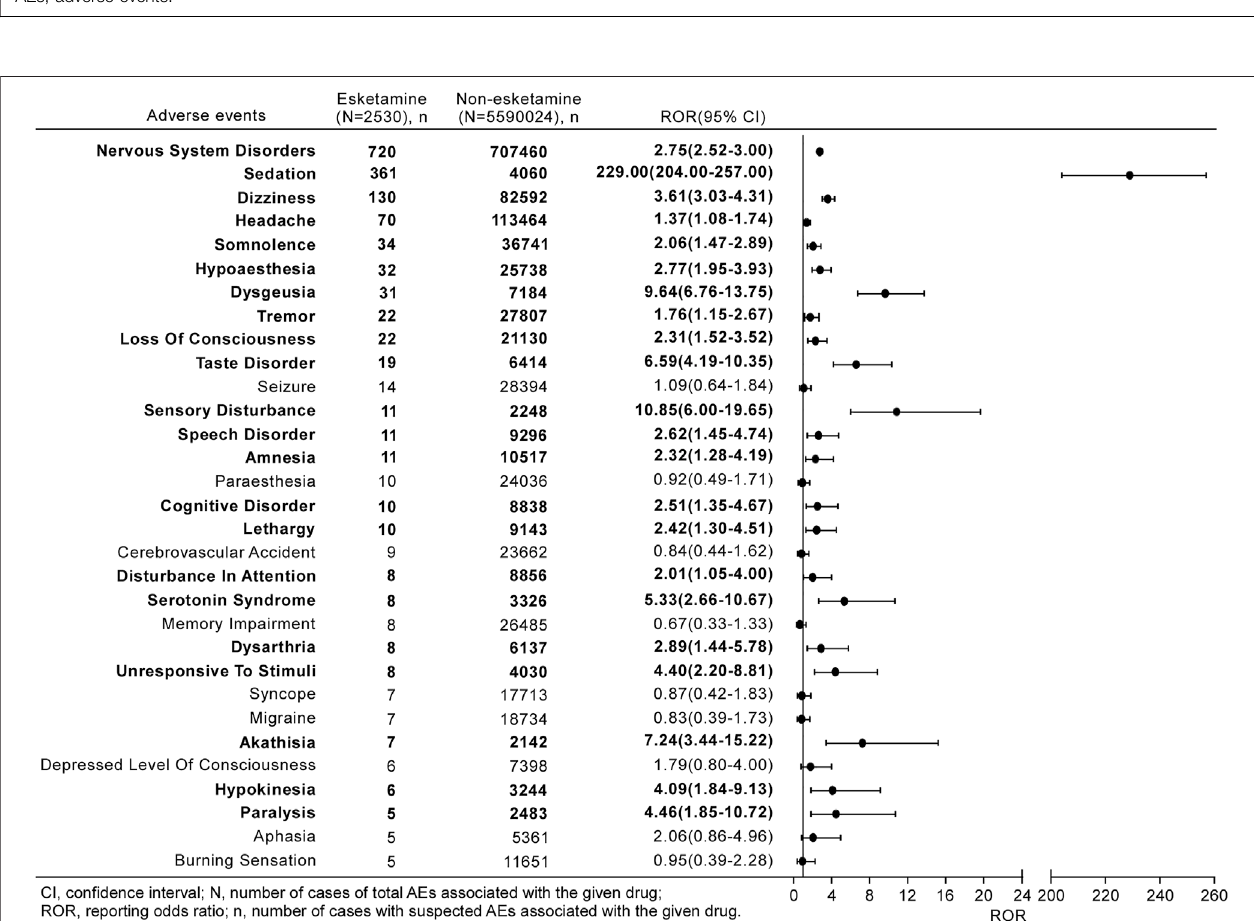
FIGURE3| Reportingoddsratios(ROR)with95%CIforallesketamine-relatedneurologicalAEswithatleast fi vecounts.Resultsthatarestatisticallysigni fi cantare in bold.